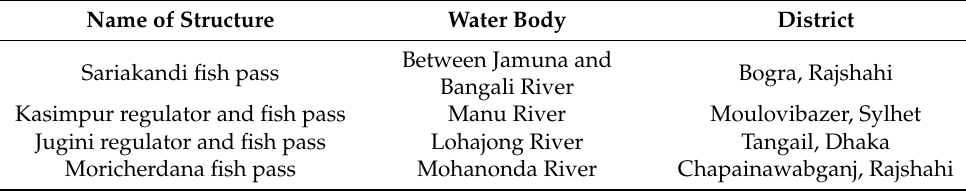
Table 7. Fish migration friendly structures in Bangladesh.